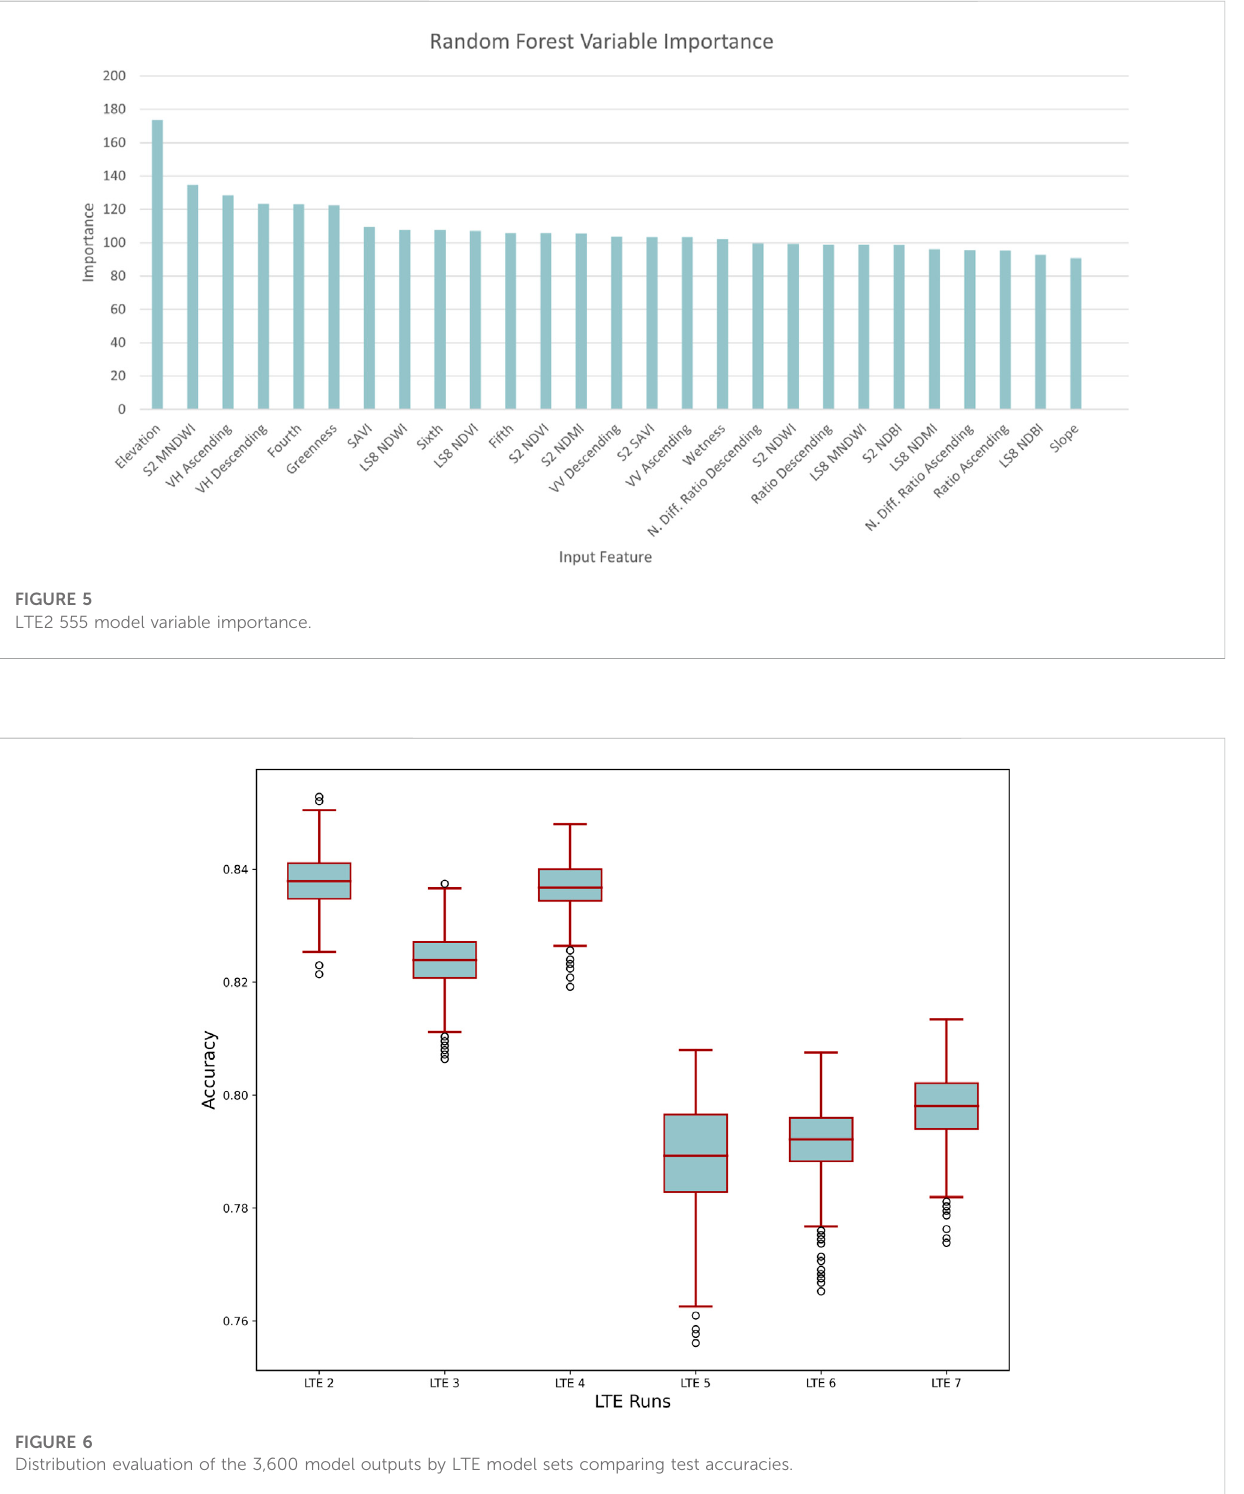
7 displayed lower median accuracies and a wide range of variability.